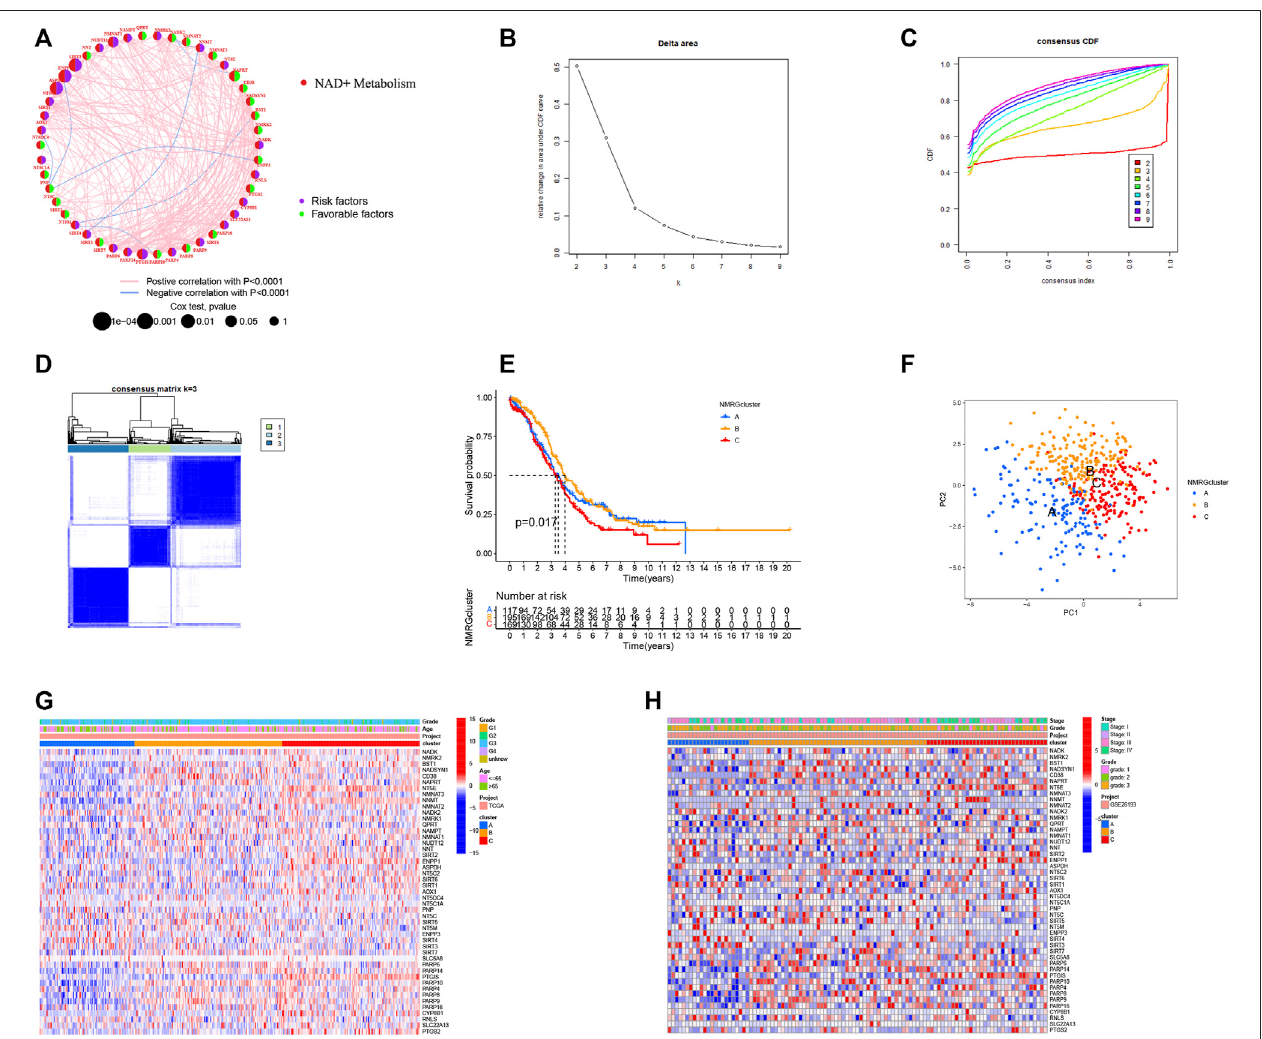
FIGURE 4 | Identi fi cation of NMRGs-related subtypes in OC patients. (A) A risk network for NMRGs. (B) Consensus clustering cumulative distribution function (CDF)for k =2to9. (C) RelativechangeinareaundertheCDFcurvefor k =2to9. (D) K =3wasarelativelystabledistinctionofthesamplesintheOCdataset. (E) Kaplan- Meier survival curve showing the relationship between NMRGs-related subtypes and overall survival. (F) Principal component analysis (PCA) analysis of NMRGcluster. The heatmap shows the clinical characteristics of different subtypes of TCGA (G) and GEO (H) patients.